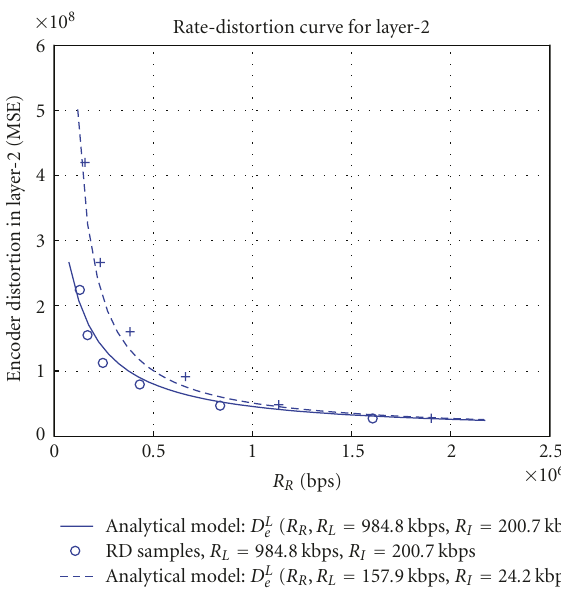
Figure 8: RD curve for layer 2 of the “Rena” video.